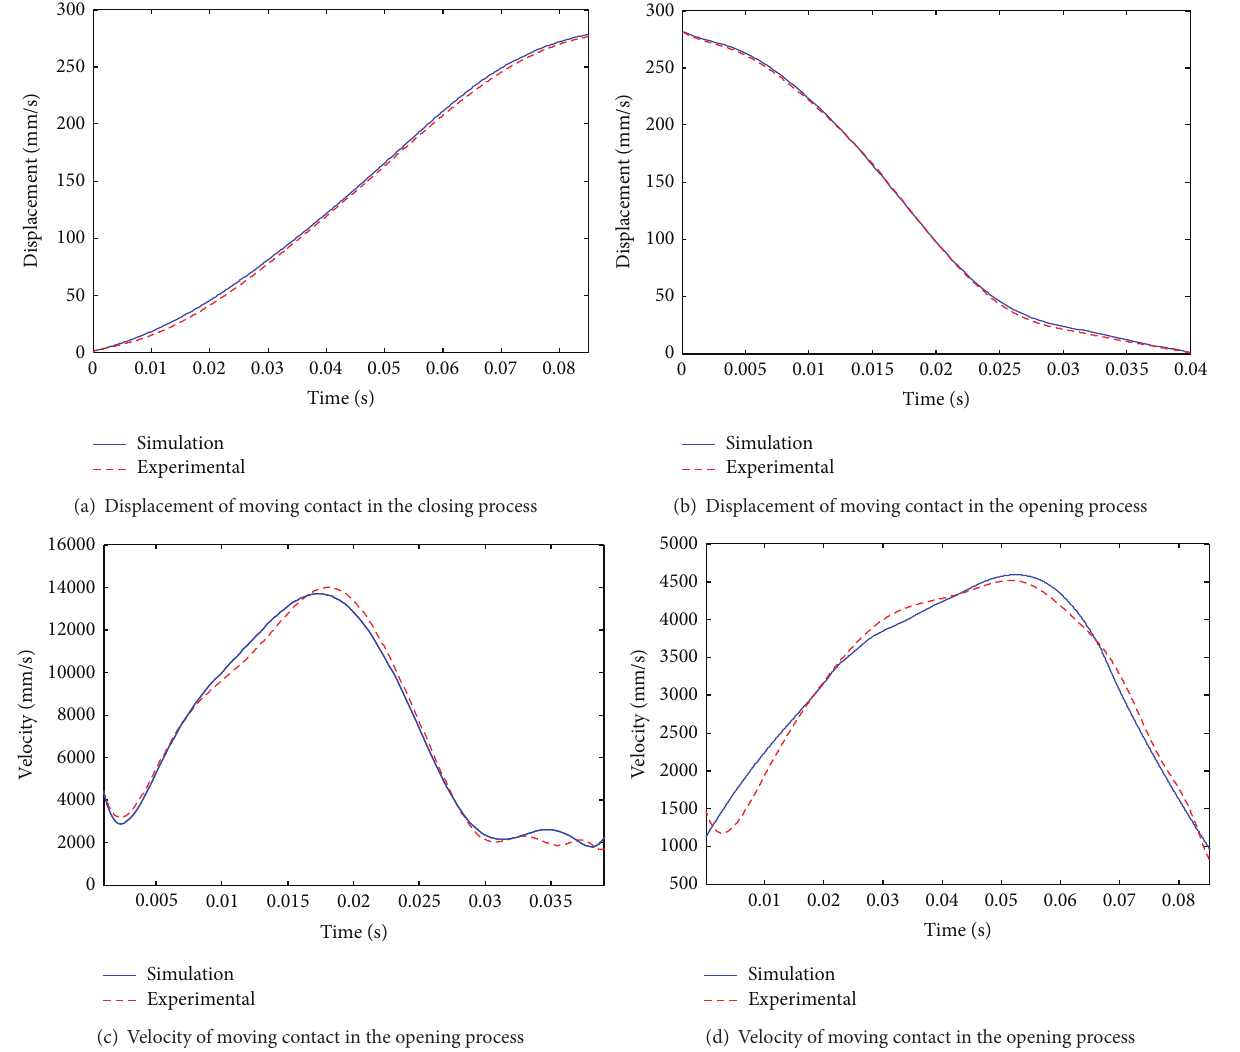
Figure 11: Simulation and experimental results.